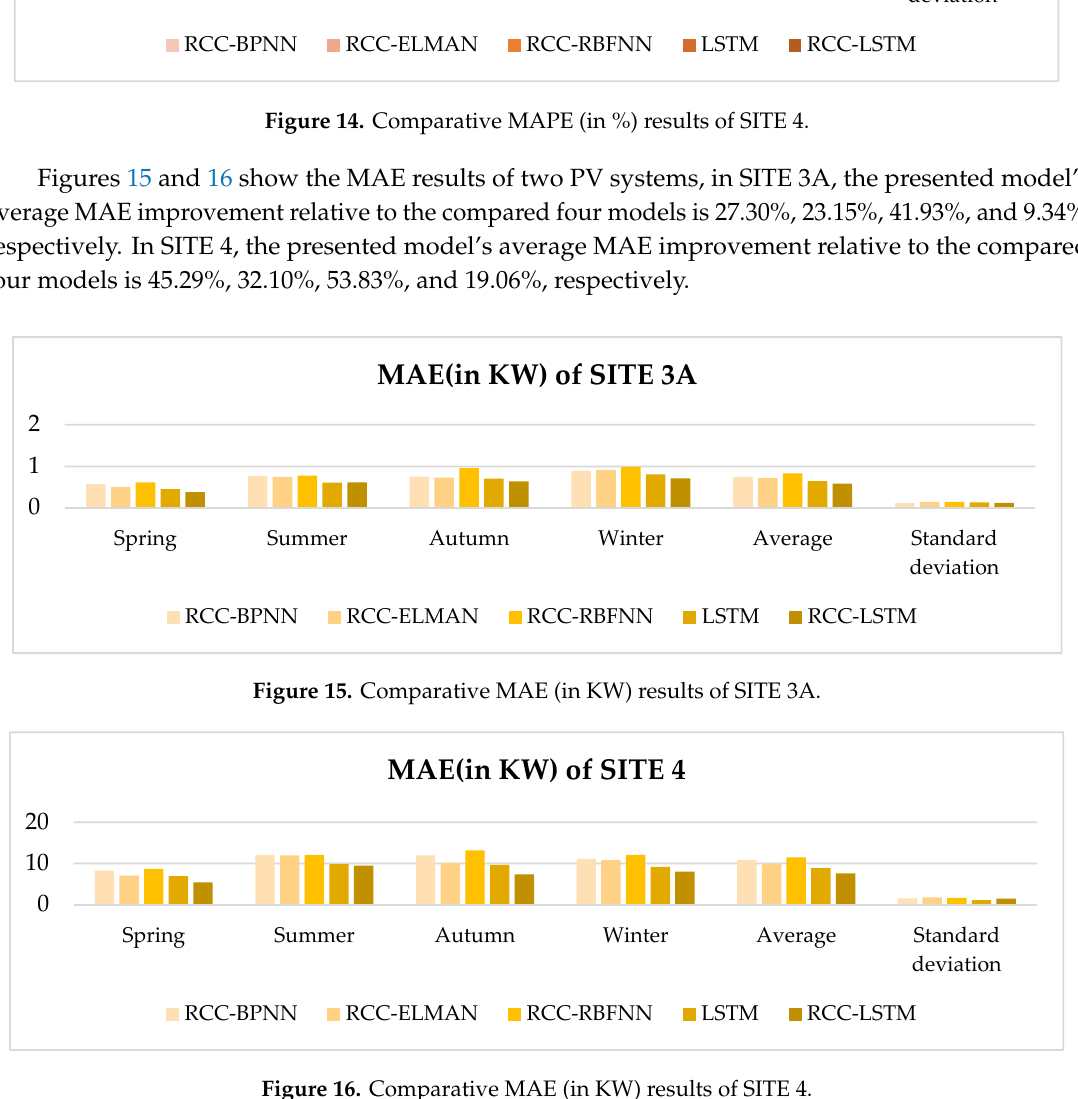
Figure 16. Comparative MAE (in KW) results of SITE 4.